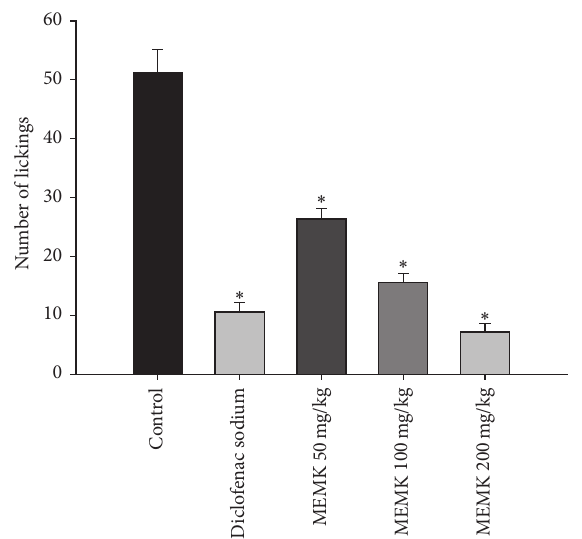
Figure 3: Effects of MEMK on glutamate-induced nociception in mice. Each group represents the mean ± SEM ( 𝑛 = 5–7). Statistical analysis was performed using one-way ANOVA followed by Dun- nett’s post hoc test. ∗ 𝑝 < 0.01 compared to control.